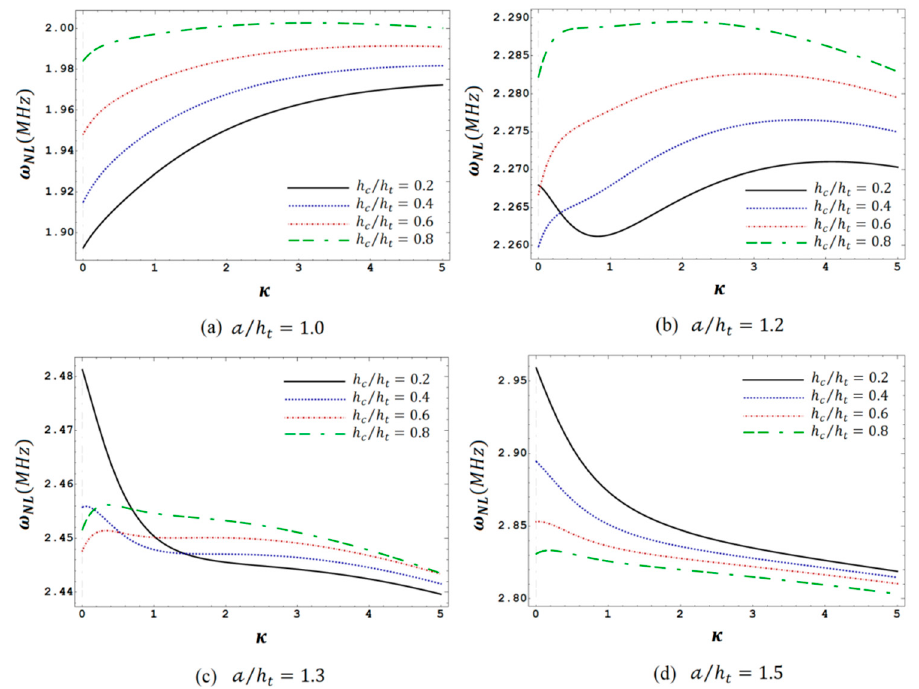
Figure 5. Variation of the first-order nonlinear frequency of a GPL-reinforced sandwich beam due to increasing power-law parameter for di ff erent core-to-beam thickness ratios and amplitudes of vibration ( N = 10, Γ b = 1%, L / h t = 10 ).